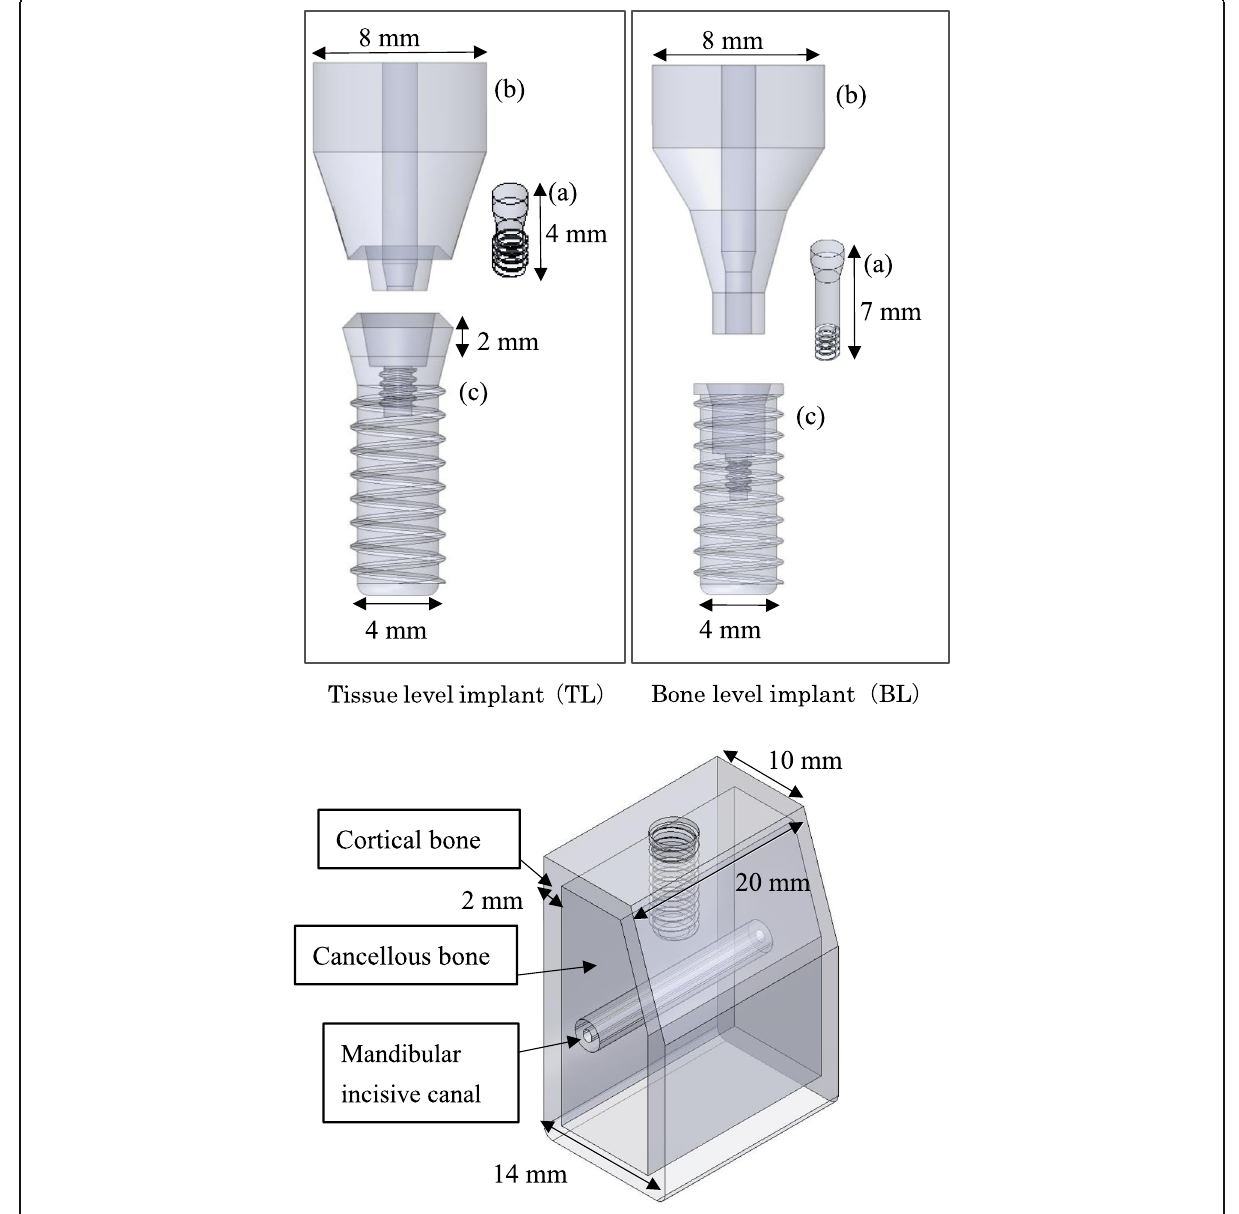
Fig. 1 Three-dimensional CAD model. (upper: a abutment screw, b superstructure, c implant body; Lower: bone